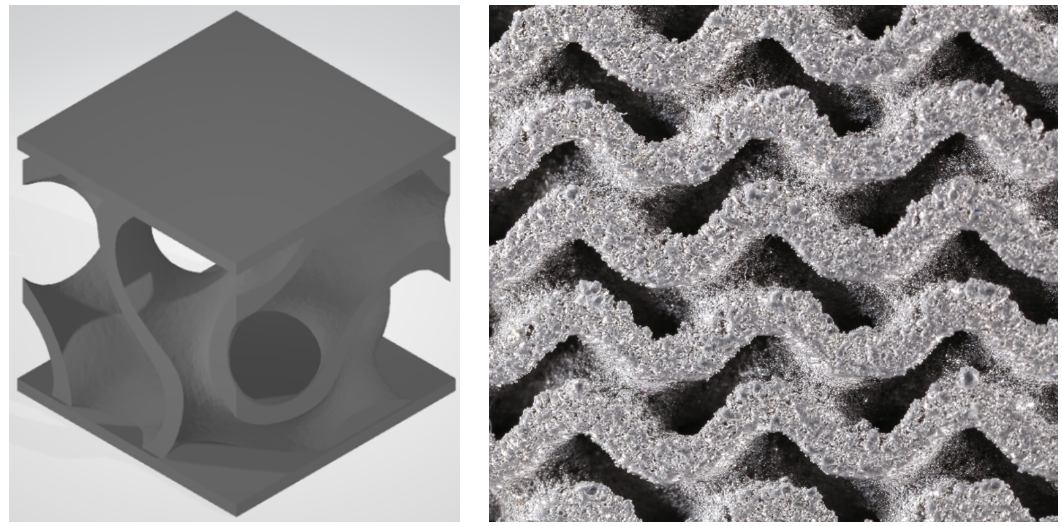
Figure 1. A model of a sample unit cell of the gyroid structure with end blocks (left) and a microscope image of a real, 3D-printed gyroid structure specimen (right) dedicated to macromechanical tests. As the cell is repetitive, the model can be made by multiplication of the unit cell. Material of the print is Ti-6Al-4V.